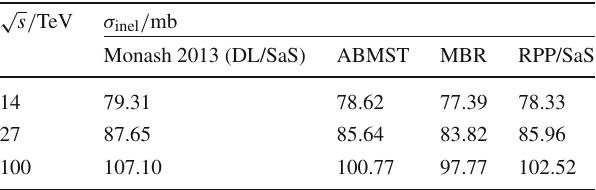
Table 5 Table comparing predictions for the inelastic cross section at √ s = 14,27,100TeV √ s / TeV